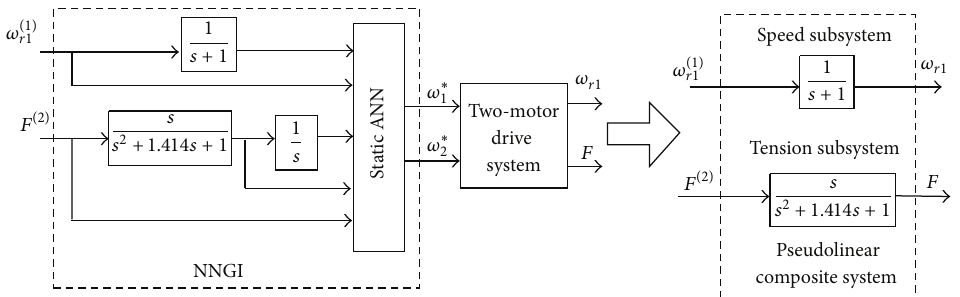
Figure 3: Pseudolinear composite